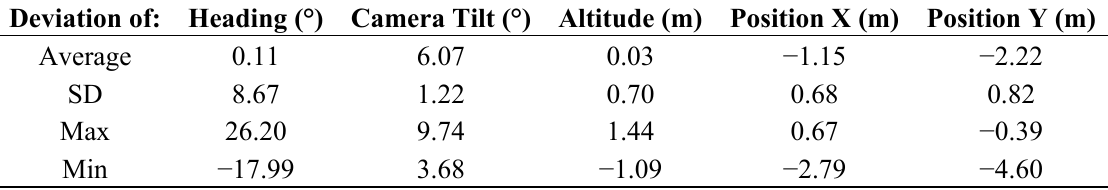
Table 4. Accuracy of the unmanned aerial vehicle (UAV) heading and spatial positioning calculated by structure from motion using 75 high-resolution images. Nine images were unusable due to motion induced “blur” and excluded from processing. Heading and tilt columns represent the deviation of the cameras actual pointing direction to the programmed angle. Altitude, X- and Y-position describe the deviation of the UAVs position as calculated from the differential-Global-Positioning-System ground-referenced structure from motion approach compared to the programmed